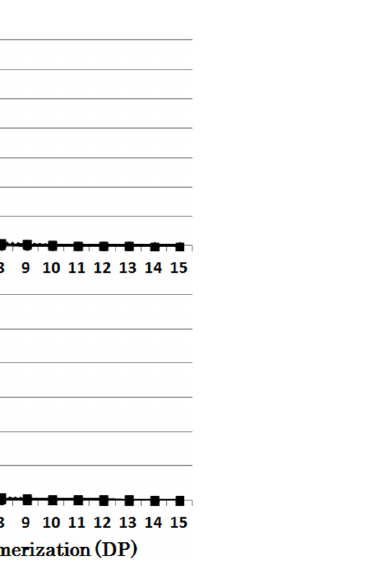
Fig 6. Chain-length preference of Escherichia coli GlgX (EcoGlgX) in debranching phytoglycogen. Upper panel shows the amount of chains liberated after enzymatic reaction with EcoGlgX and phytoglycogen for 5 ( ● ), 10 ( ▲ ), and 30 ( ■ ) min, respectively. Lower panel shows the molar percentage of each liberated chain to the total liberated